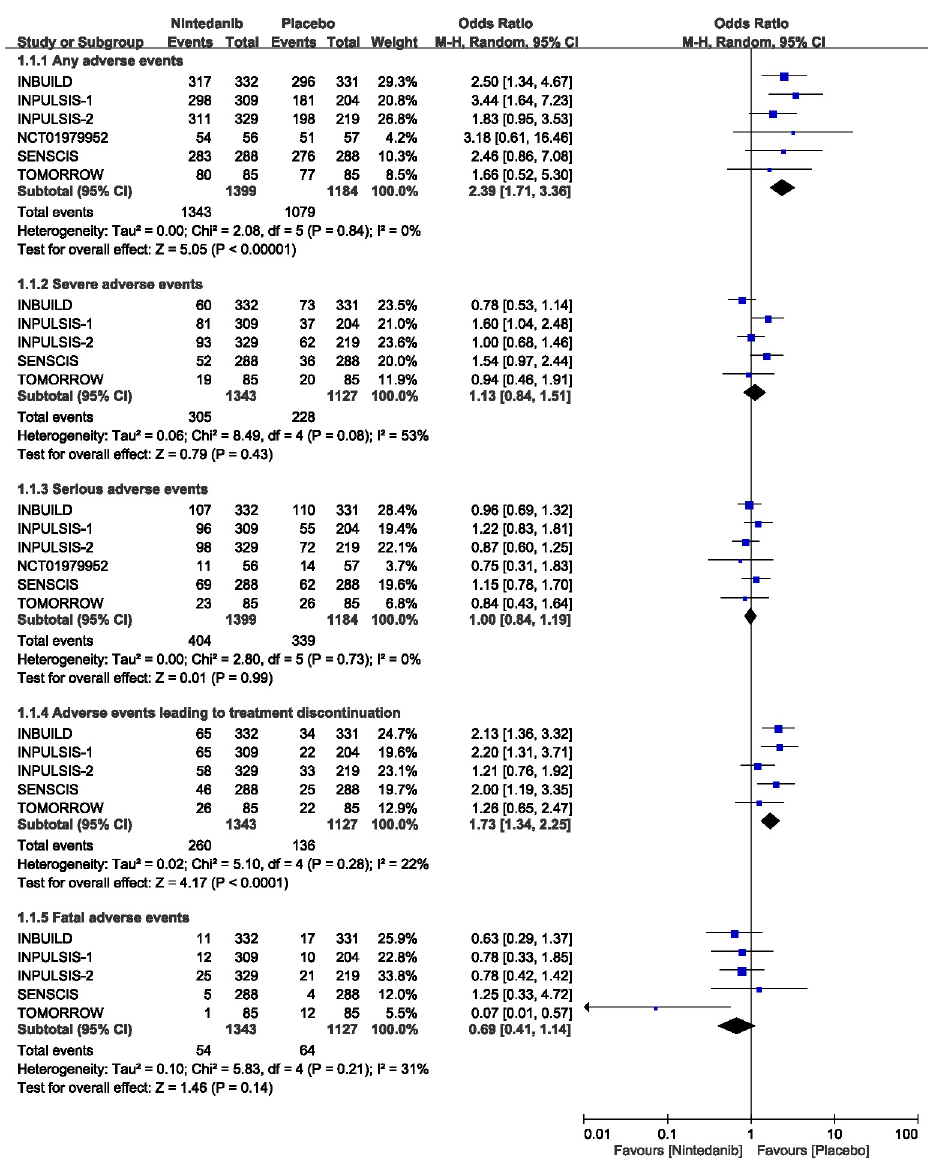
Fig 2. Forest plots for association between adverse events and use of nintedanib. NCT01979952 was not showed up in 1.1.2, 1.1.4 and 1.1.5 for no results